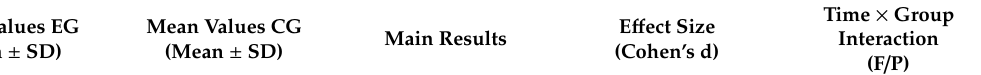
Table 4. Results of the studies included in the